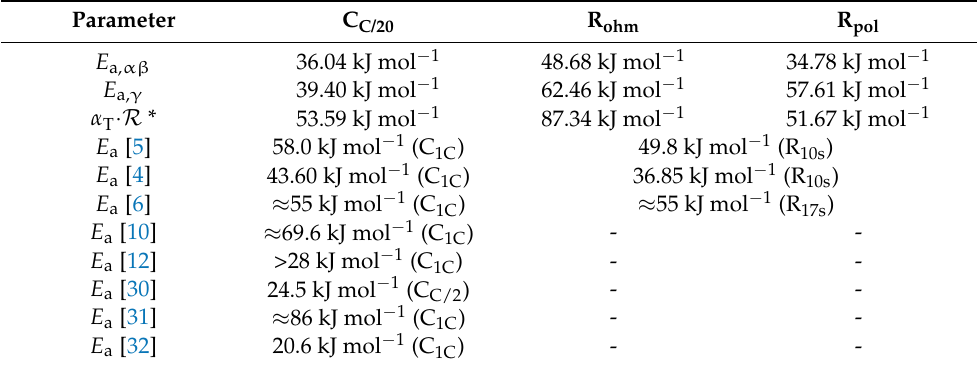
Table 6. Arrhenius activation energies ( E a ) of the two 4D fit model parts and comparison with values from the literature.